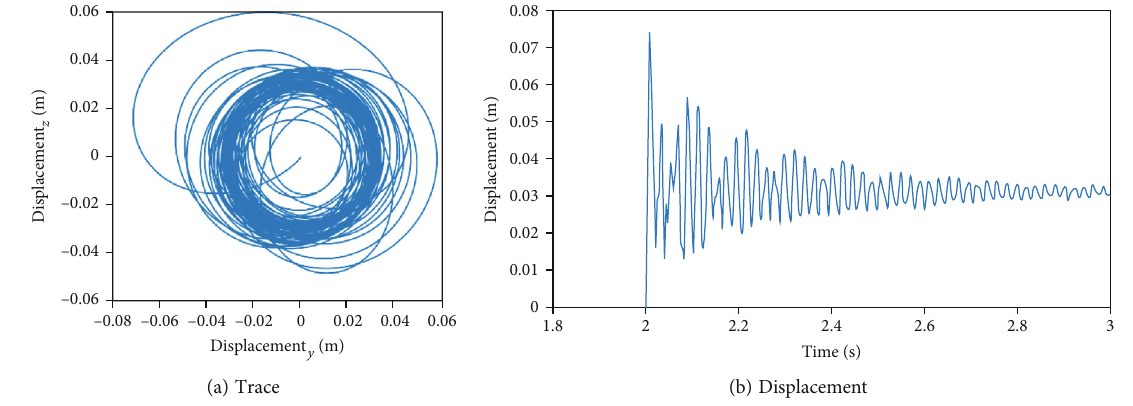
Figure 20: Response of a low-pressure compressor disk with rub impact. Table 8: Response of a low-pressure compressor disk with rub